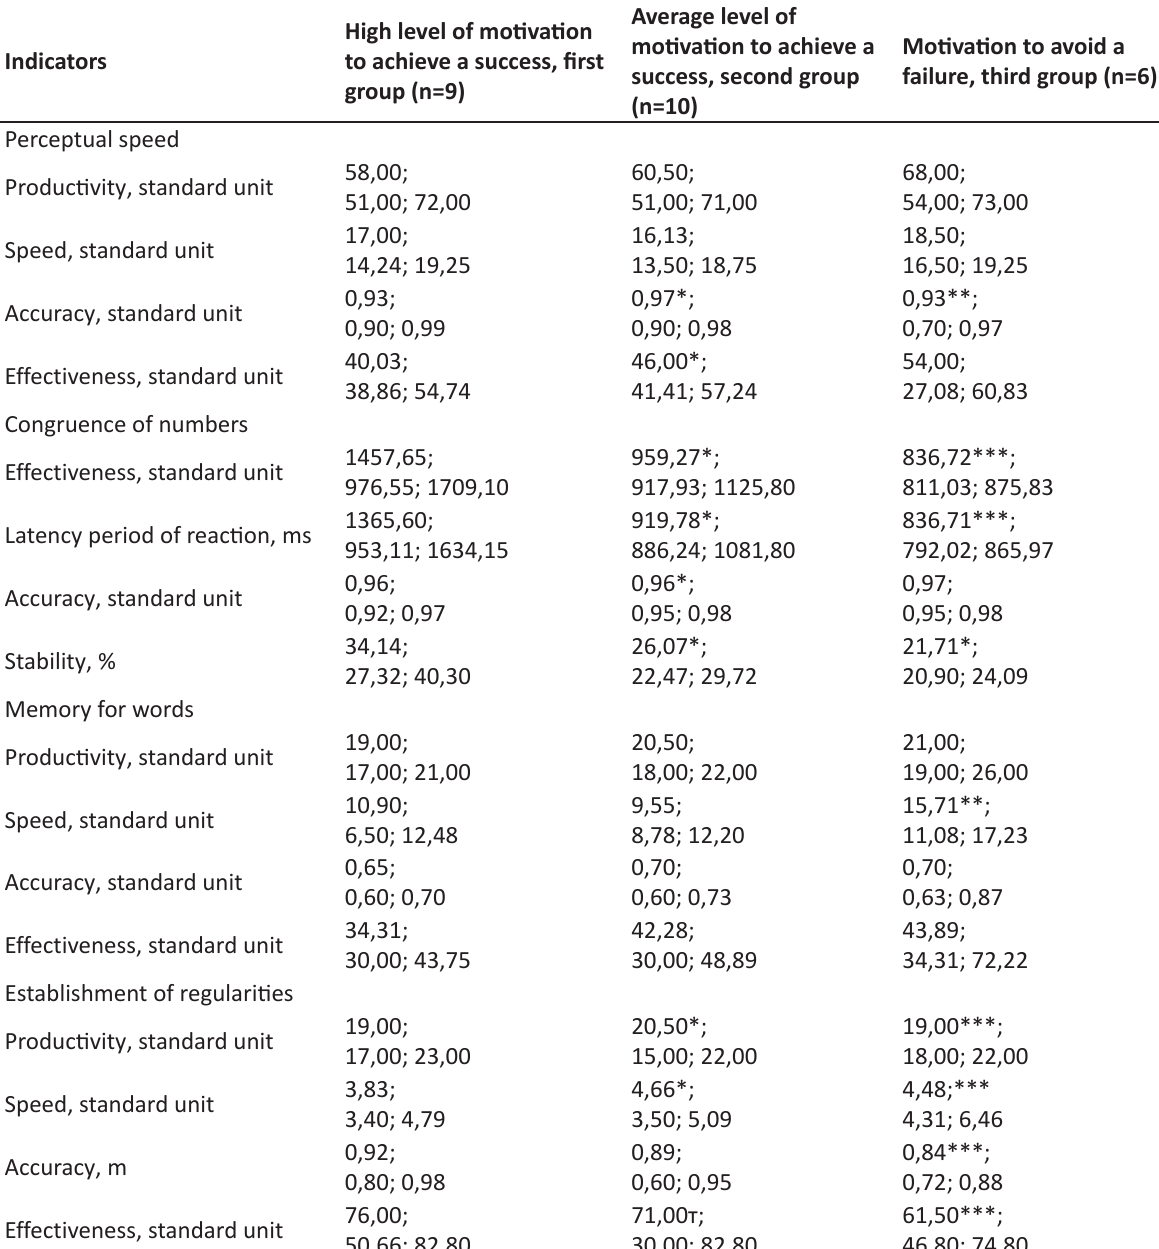
Table 2. Cognitive functions of high qualification judo athletes with different levels of motivation (median, lower quartile, upper quartile)